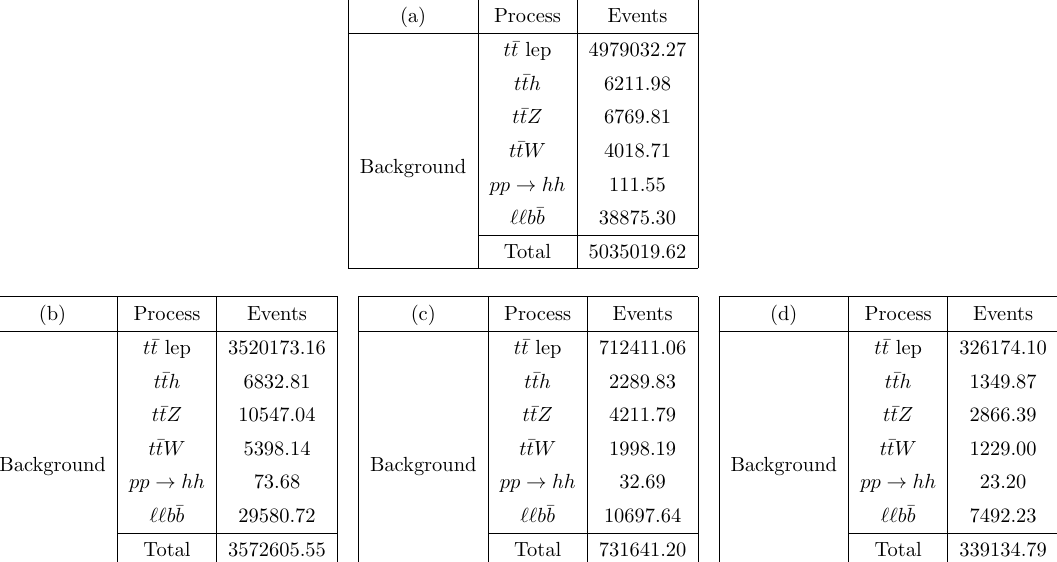
T channel after the BDT analyses